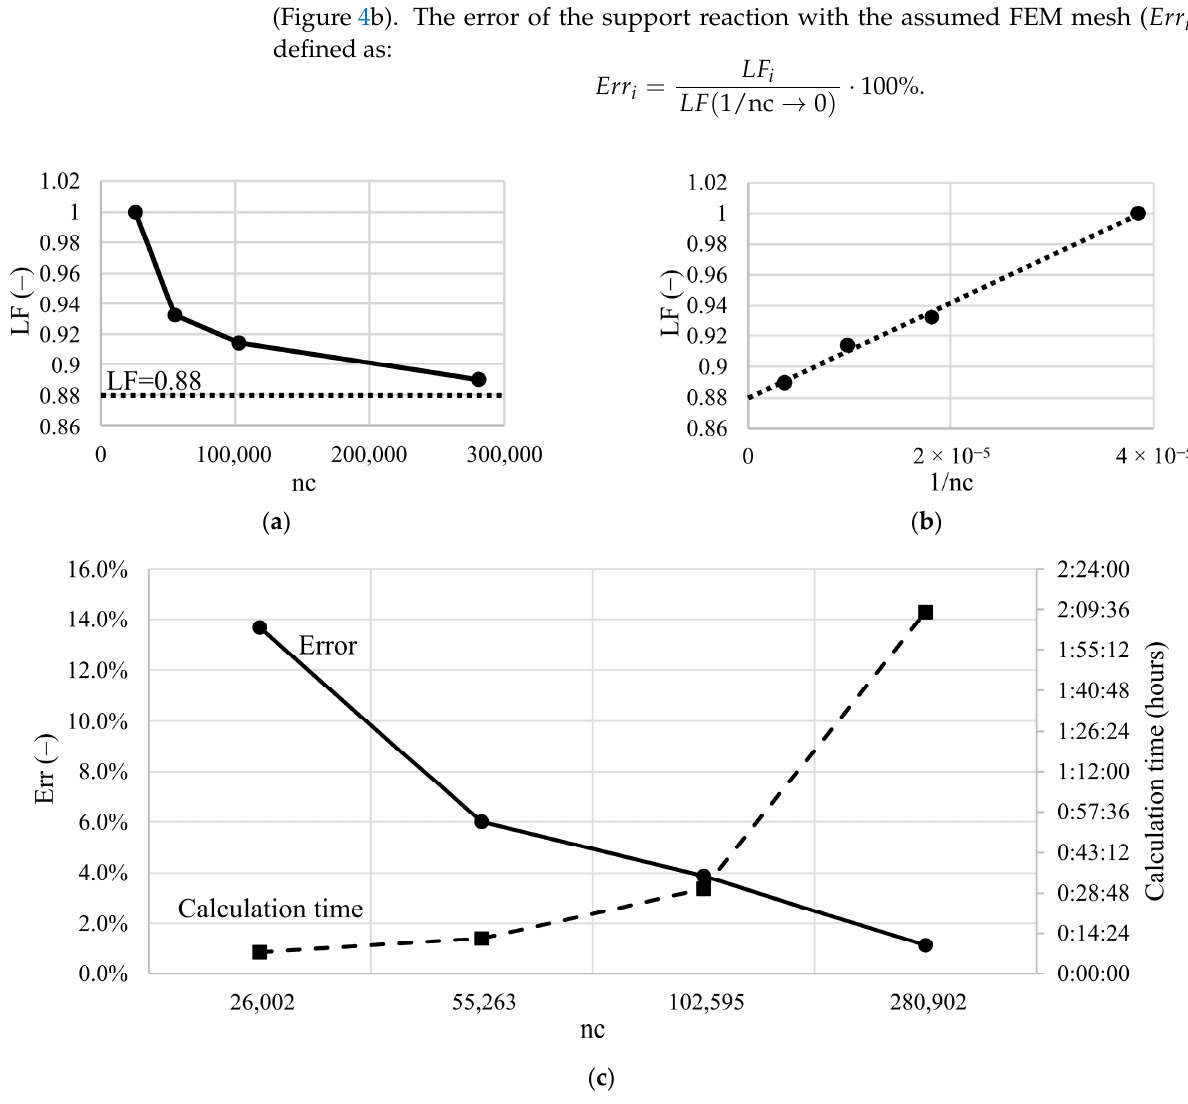
Figure 4. Convergence analysis—( a ) normalized force depending on number of nodes; ( b ) normalized force depending on 1/number of nodes; ( c ) error and calculation time depending on number of nodes.